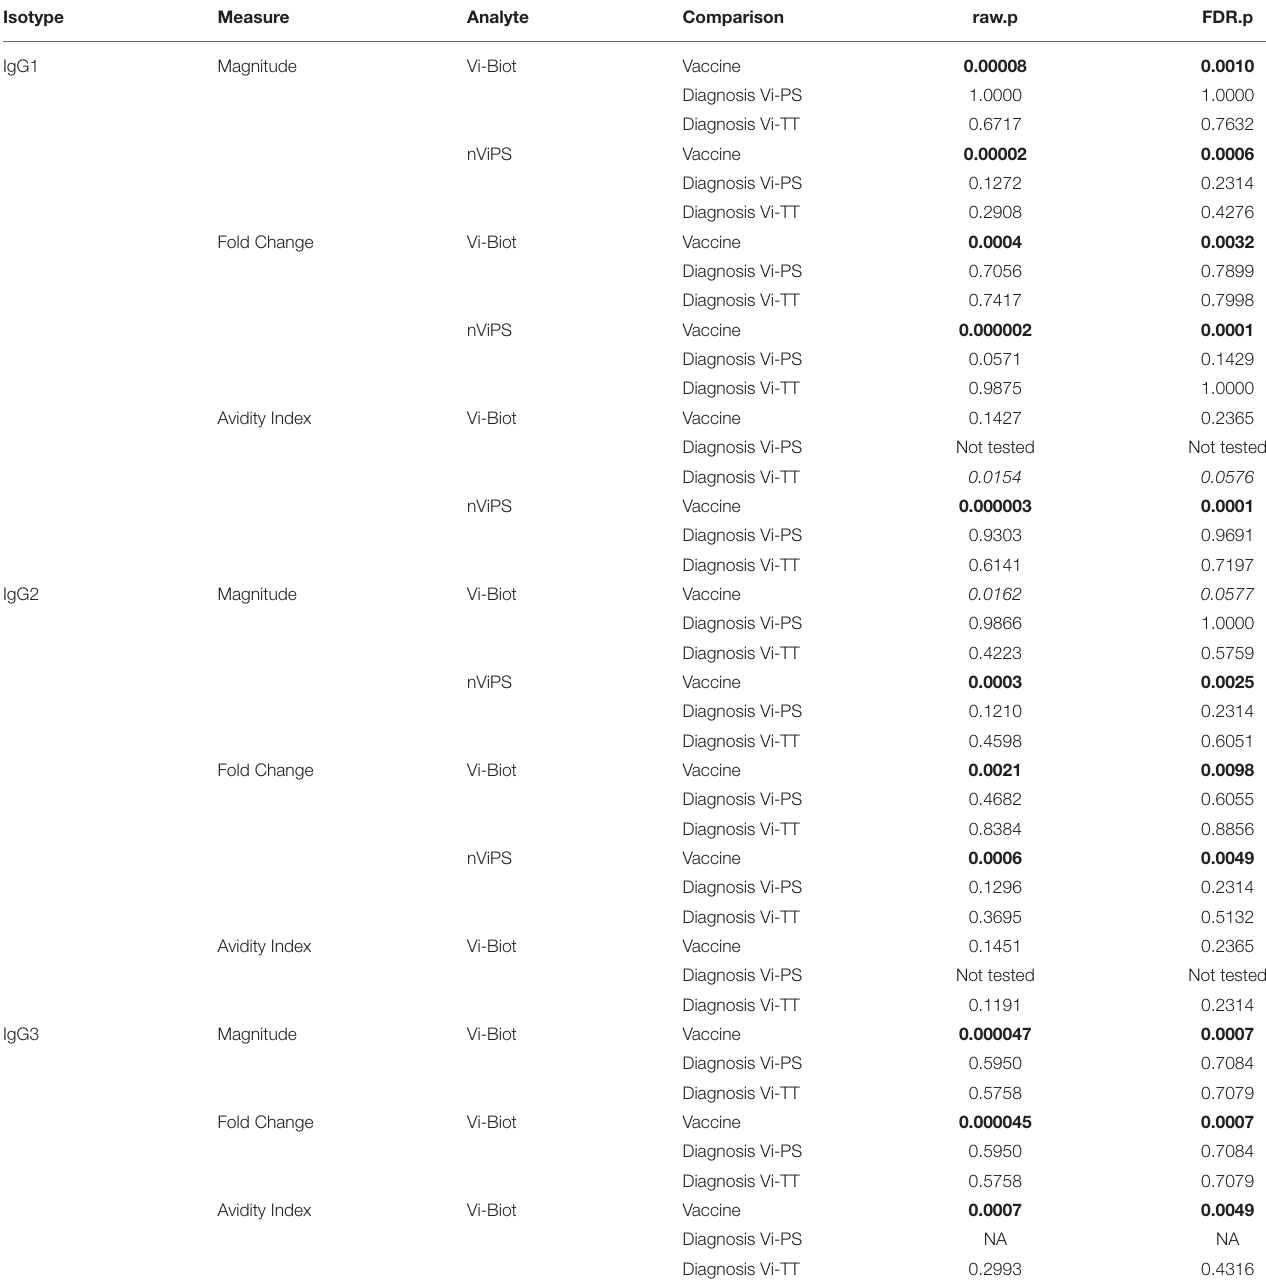
TABLE 3B | Primary statistical analysis of IgG responses to Vi at Day of challenge